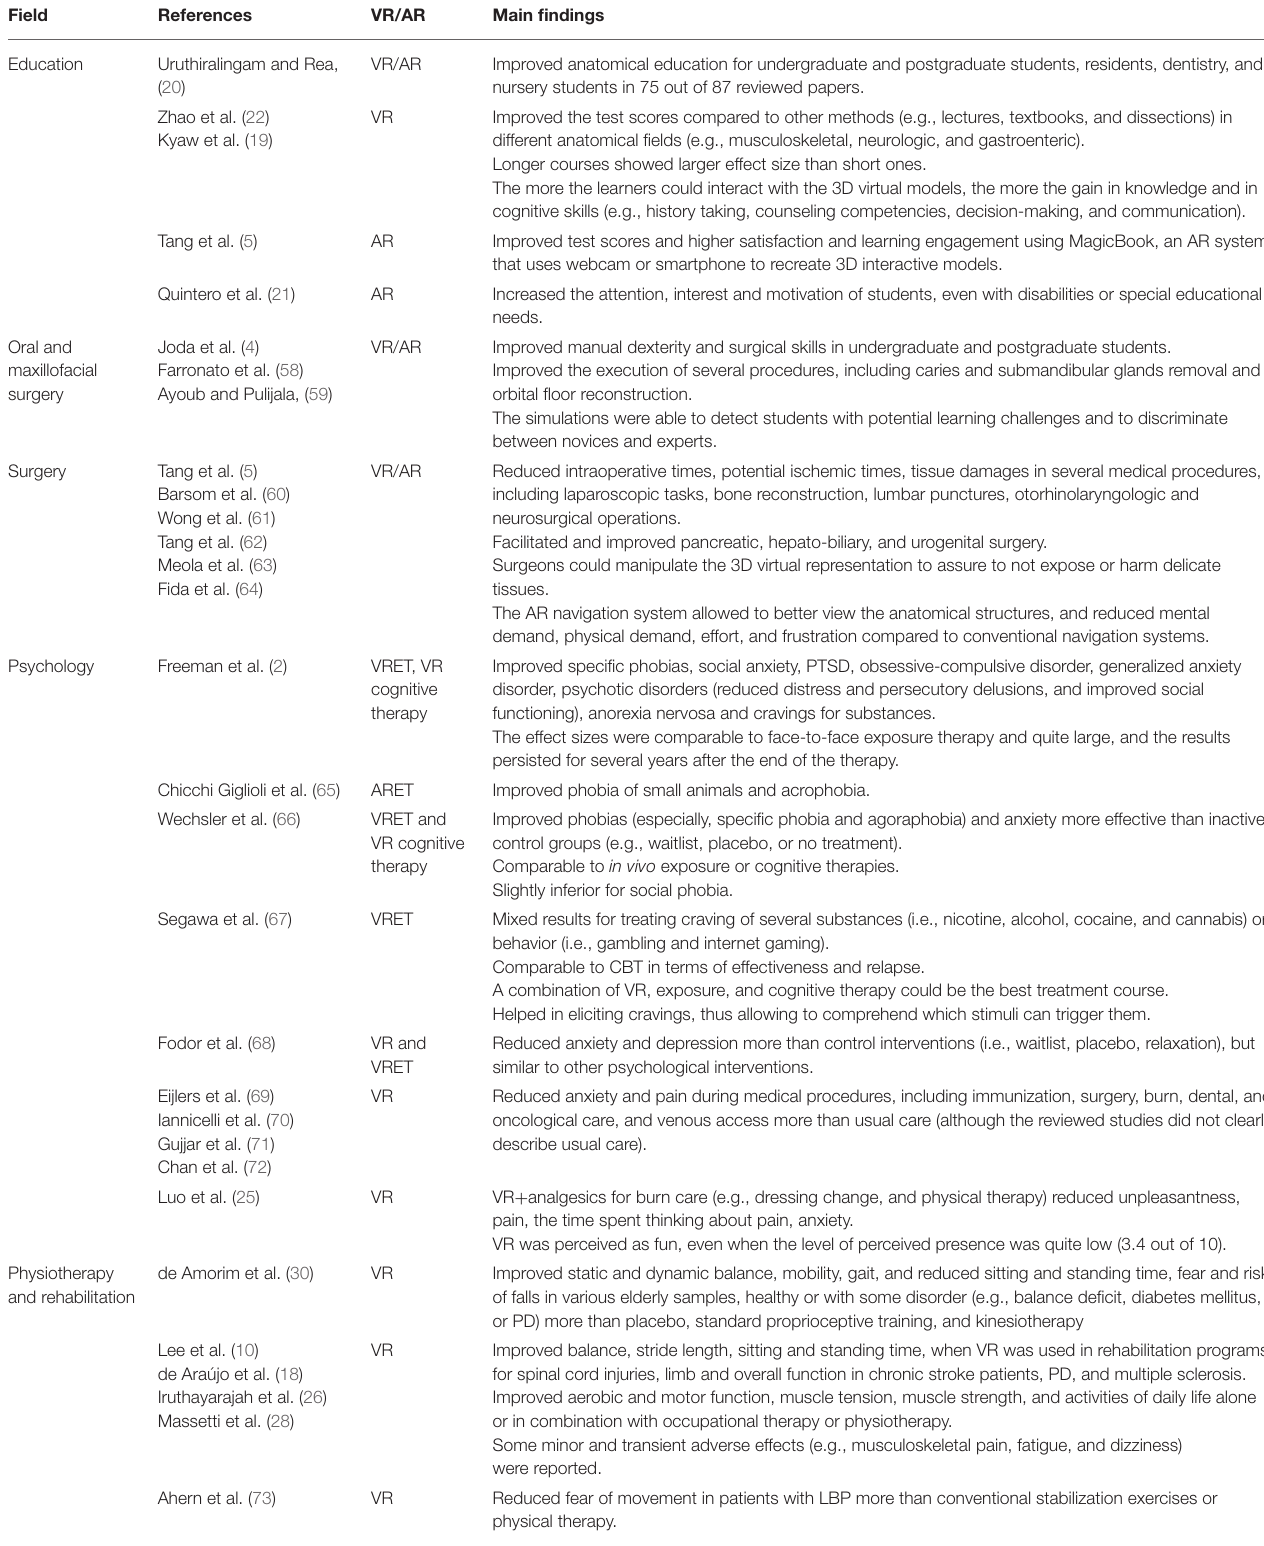
TABLE 1 | A summary of the main findings of the systematic reviews about VR and